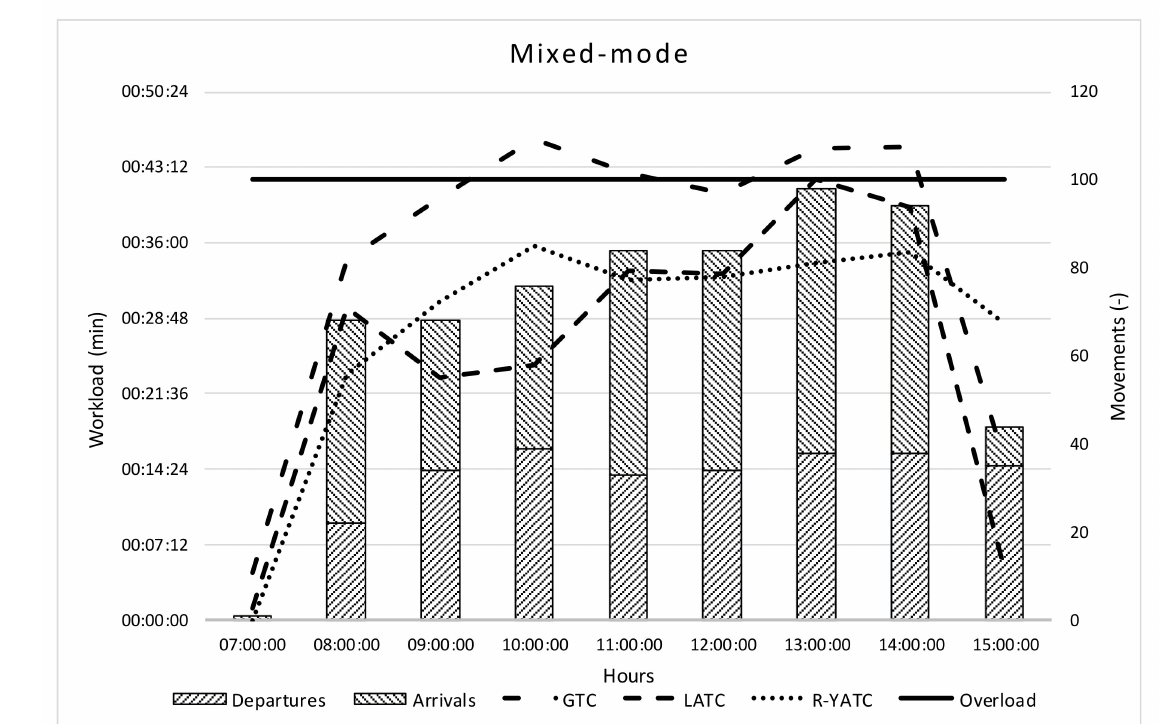
Figure 4. Workload e throughput mixed-mode.